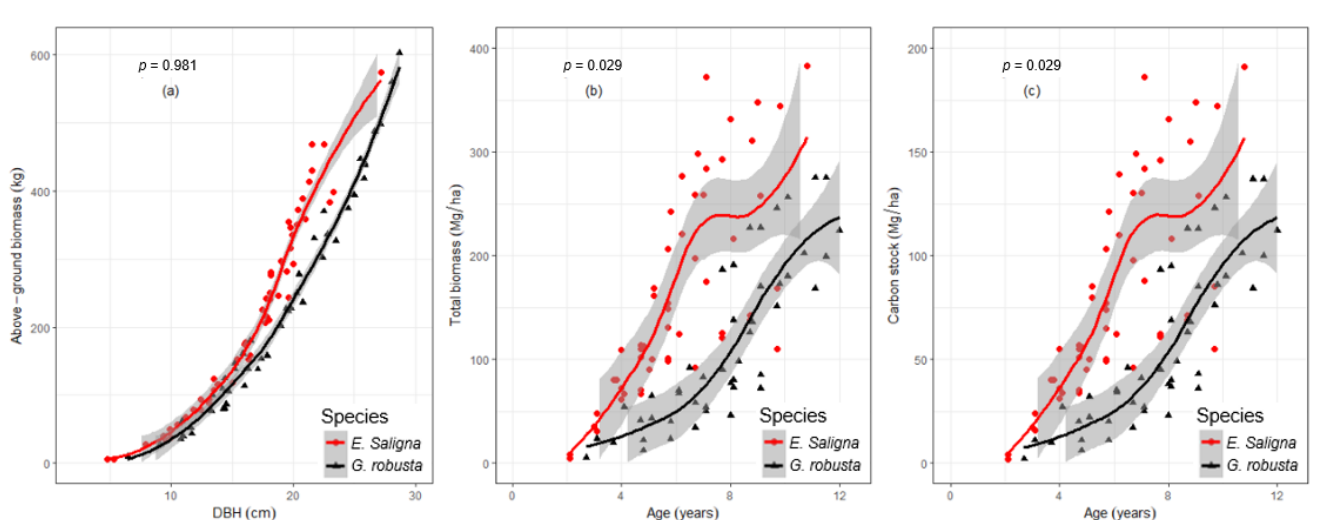
Figure 7. Dynamics of biomass accumulation and carbon storage as a function of tree diameter ( a ) and stand age ( b ) and ( c ) in E. saligna and G. robusta plantations in North Kivu. The probability ( p ) given is that of Student’s t -test.